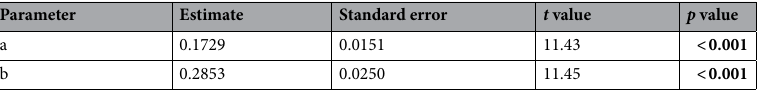
Table 1. Parameter estimates from the power function by least squares method on the relationship of duration and bias (observed species richness of eBird vs. average observed species richness of BBS). The power function is depicted in Eq. (5) with parameters (a and b) to be estimated. Residual standard error 0.2692 on 562 degrees of freedom. Significant parameters are shown in bold.